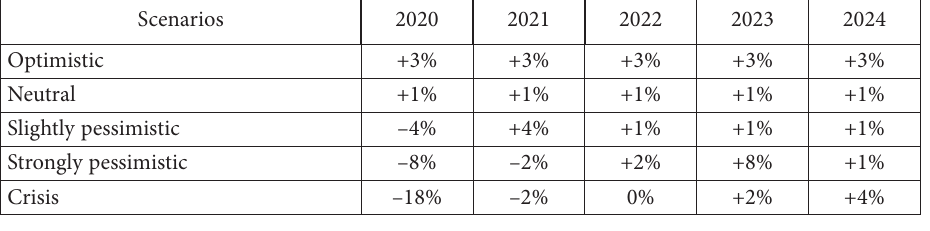
Table 7. Changes used in the factors for forecasting scenarios of the multiple linear regression model (source: authors)